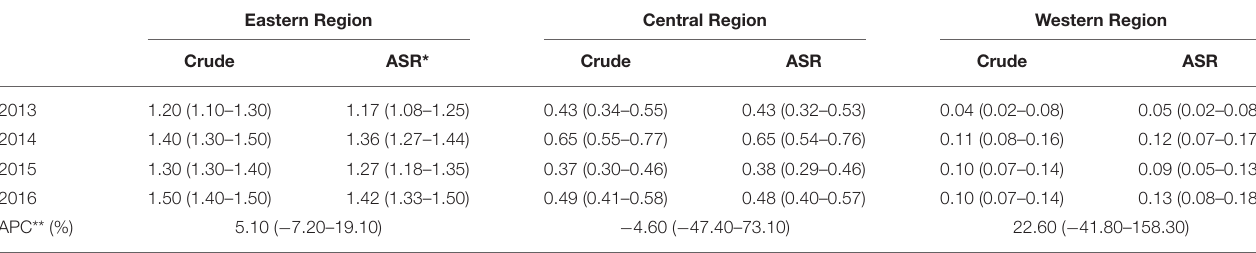
TABLE 12 | Annual crude and age-standardized incidence rate of Crohn’s disease among urban employees in three regions of China from 2013 to 2016 (per 100,000 persons). Eastern Region Central Region Western Region Crude ASR* Crude ASR